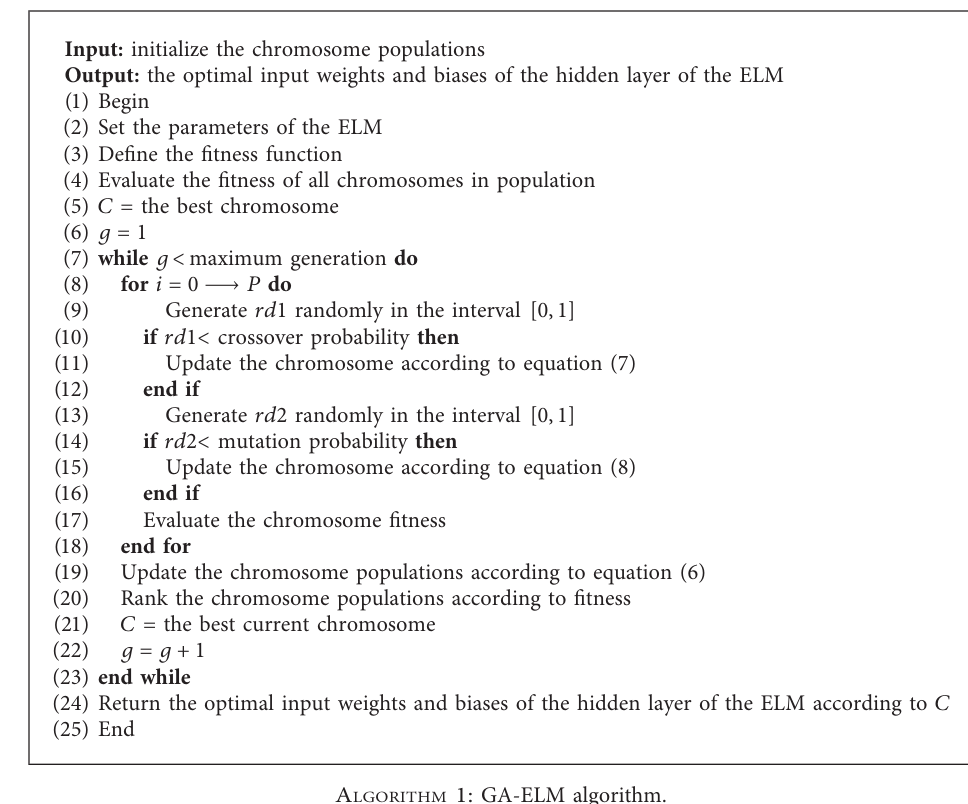
A LGORITHM 1: GA-ELM